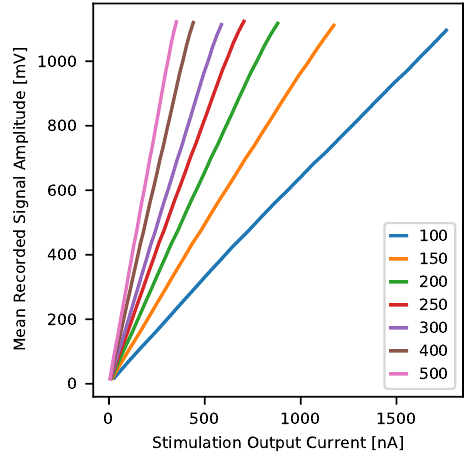
Figure 20. Sampled signal amplitude of the test channel resulting from stimulation output current for different gain